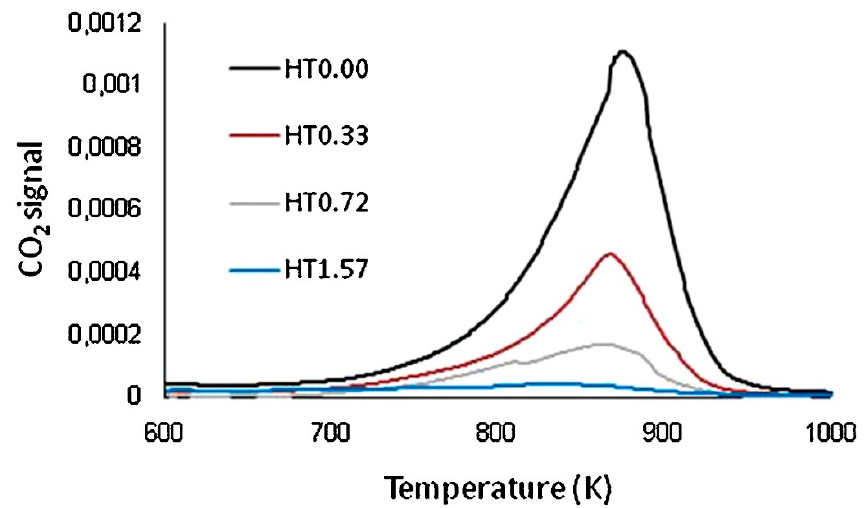
Figure 12. TPO profiles of LDH-derived mixed oxides with different Mg/Ni molar ratios (number in each sample) used in ESR. Reprinted with permission from Ref. [122]. Copyright 2022 Elsevier.